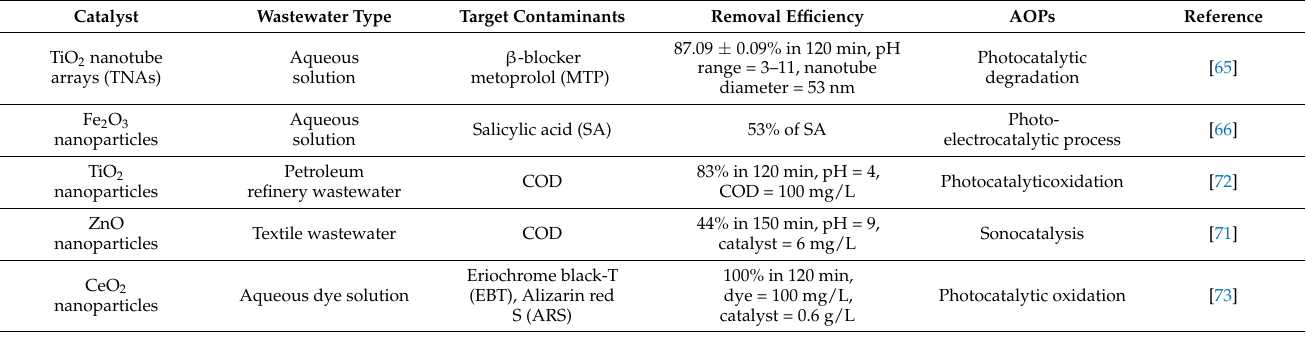
Table 5. Metal oxides in AOPs for wastewater treatment.